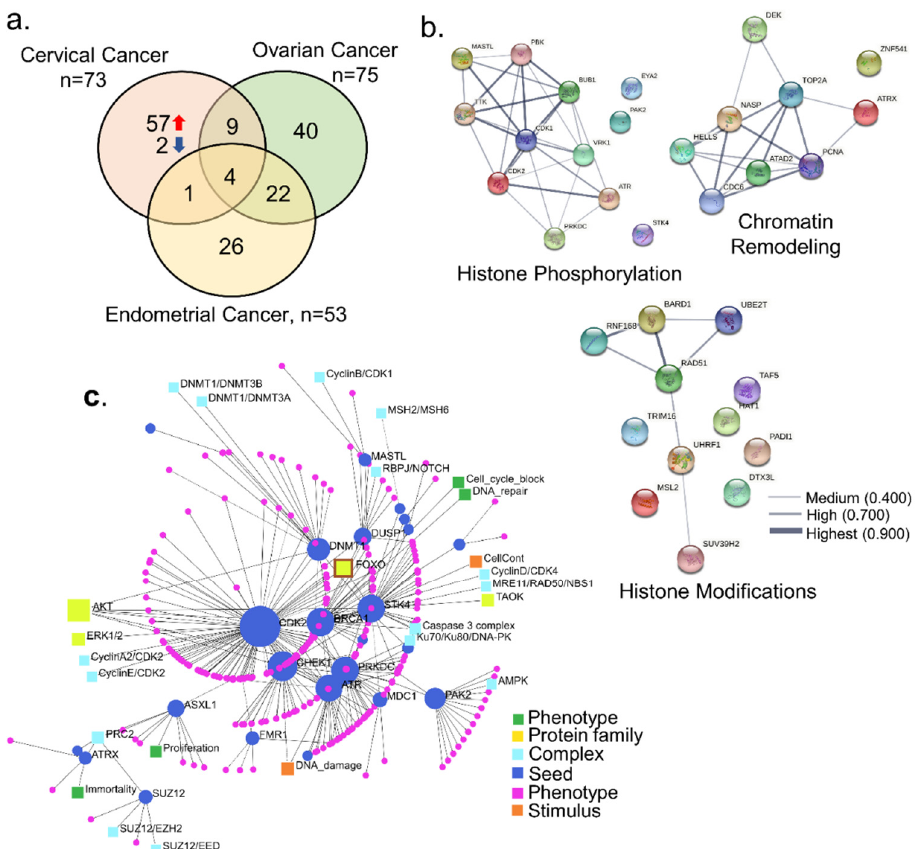
Figure 2. Significance of cervical-cancer-specific epigenomic and chromatin regulators. ( a ) Venn diagram representing the intersection of differentially expressed epigenomic regulators in cervical cancer with ovarian and endometrial cancer. ( b ) Protein–protein interaction of functional clusters; the color of the edge represents the strength of interaction. ( c ) The concentric circle image represents signaling enrichment of 57 epigenomic and chromatin